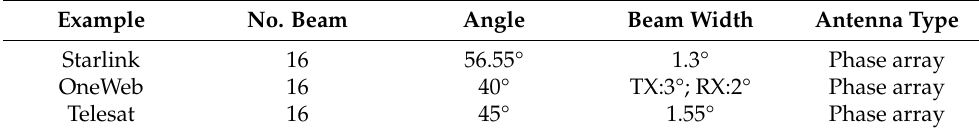
Table 1. Three large constellation beam coverage designs.